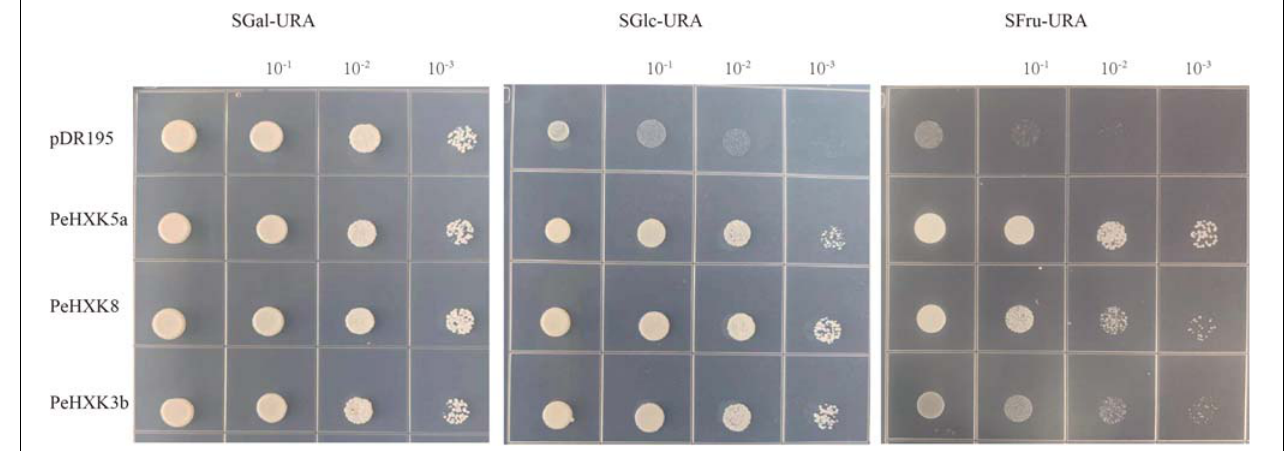
FIGURE 7 | Complementation of the yeast mutant YSH7.4-3C with PeHXK genes. pDR195: the empty pDR195 vector was transformed into YSH7.4-3C as negative control; PeHXK3b, PeHXK5a, and PeHXK8: the recombinant vectors (including the three PeHXK CDS) were transformed into YSH7.4-3C, respectively. SGal-URA, the medium that contained galactose as the sole carbon source and lacked uracil; SGlc-URA, the medium that contained glucose as the sole carbon source and lacked uracil; SFru-URA, the medium that contained fructose as the sole carbon source and lacked